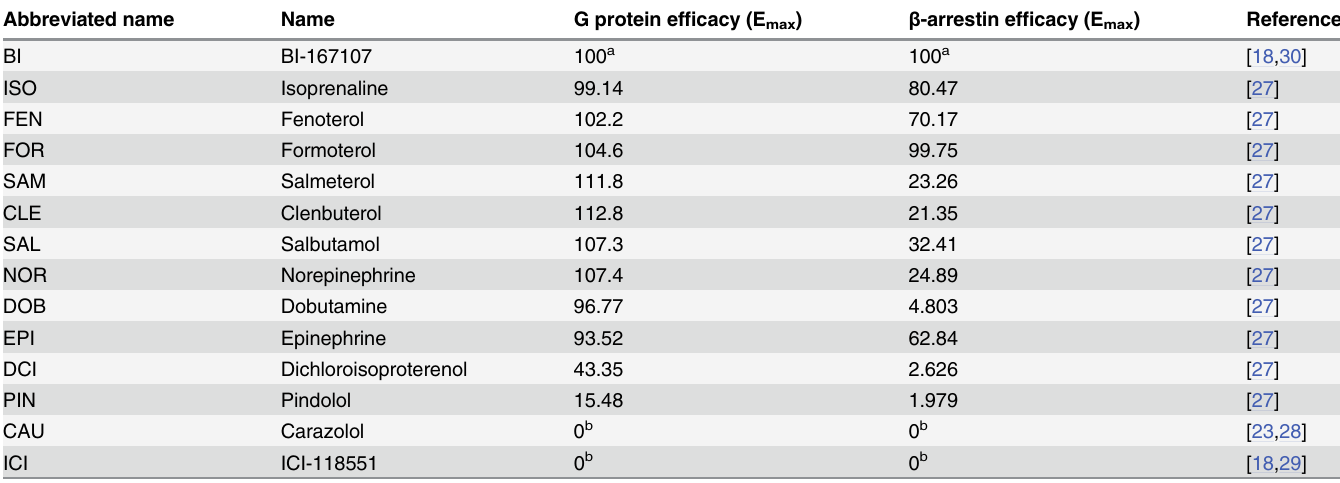
Table 1. Summary of the efficacy of 14 β 2 AR